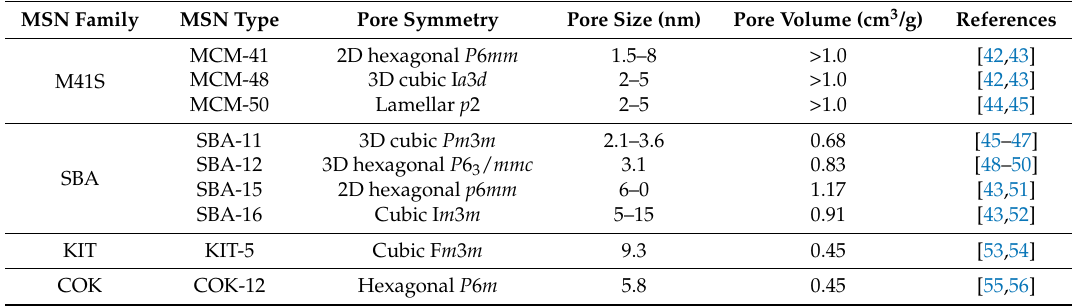
Table 2. List of some of the types of mesoporous silica nanoparticles (MSNs) and their characteristics. MSN